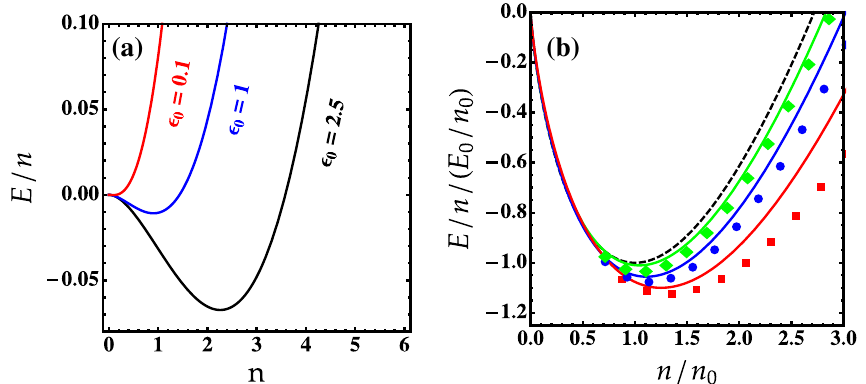
Figure 2. ( a ) The ground-state energy E / n from Eq. (8) for several values of ǫ 0 and g = 0.45 . ( b ) The ground- state energy as a function of n / n 0 . Solid lines correspond to our beyond-LHY results up to second-order in ˜ n and ˜ m . Dashed line corresponds to the Bogoliubov theory 13 . Green diamonds ( ln ( a 12 / a ) = 20 ), blue circles